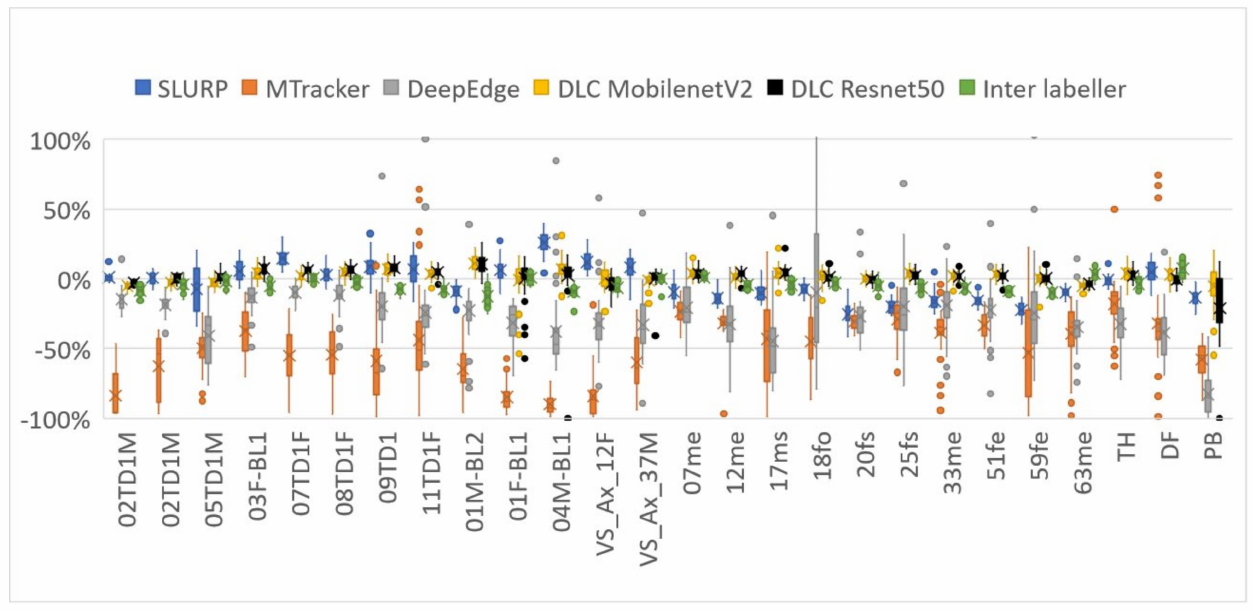
Figure 8. Relative length distance between hand contoured randomly selected frames (40 frames for each participant) and each of the assessed methods (DLC using MobileNetV2_1.0 encoder). Figure 9 shows plots of x -axis = MSD vs. y -axis = %length difference for every test frame that generate the overall results in Table 4. An ideal estimator would have all points at (0,0) (see Appendix A for why an MSD of 0.0 is unlikely). Of the three previously reported estimators, SLURP is the most robust when MSD and length are considered. The tighter cluster for DLC more closely matches the inter-labeller